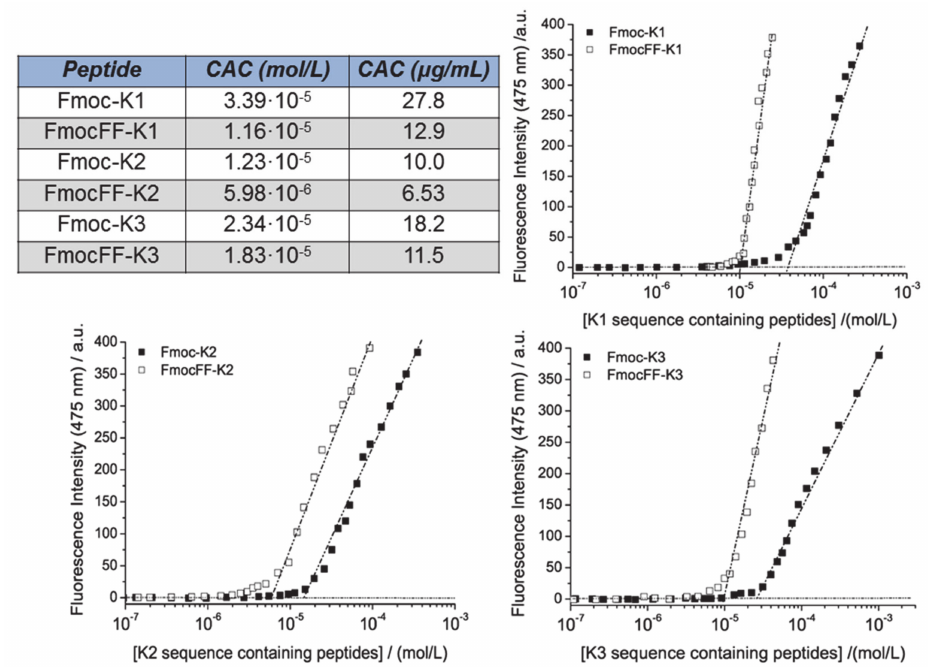
Figure 2. CAC determination. Fluorescence intensity of the ANS fluorophore at 470 nm versus the concentration of each peptide. CAC values, calculated from the break points, are reported in the Table (expressed in mol/L and in µ